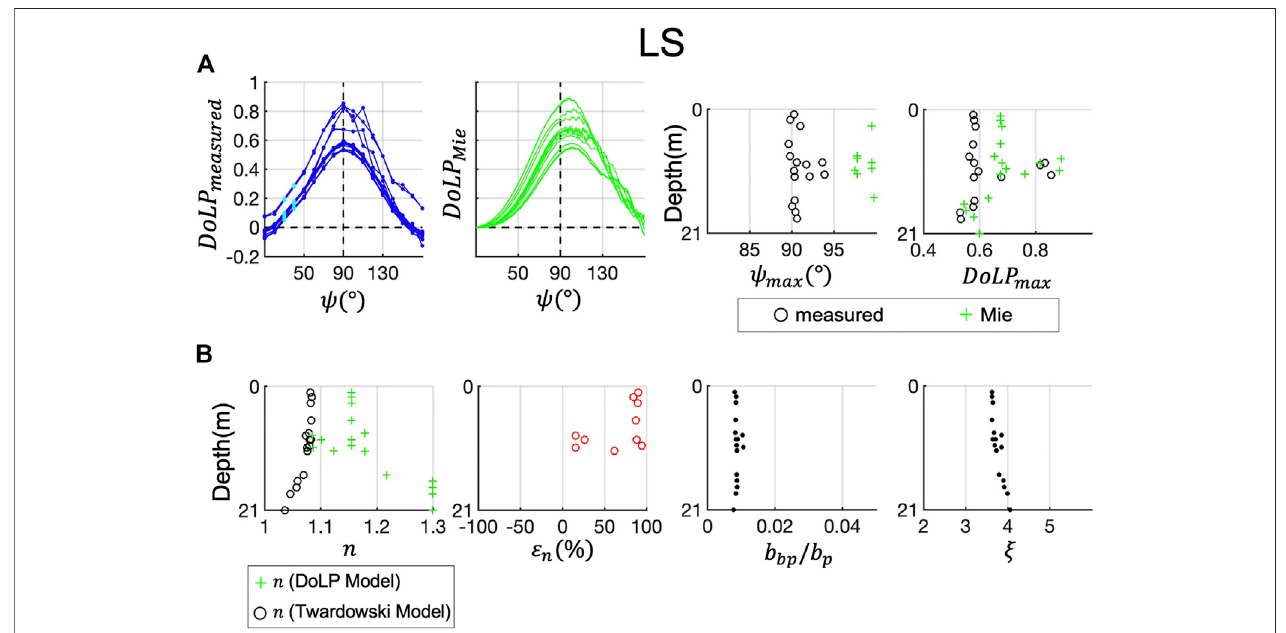
FIGURE 12 | Refractive index retrieval at fi eld site LS (Ligurian Sea). Same as Figure 9 .